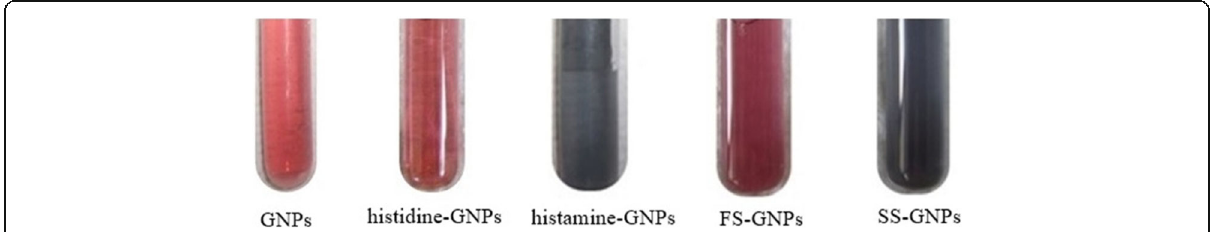
Fig. 5 Interaction between GNPs with fresh chicken meat sample (FS) and spoiled sample (SS)